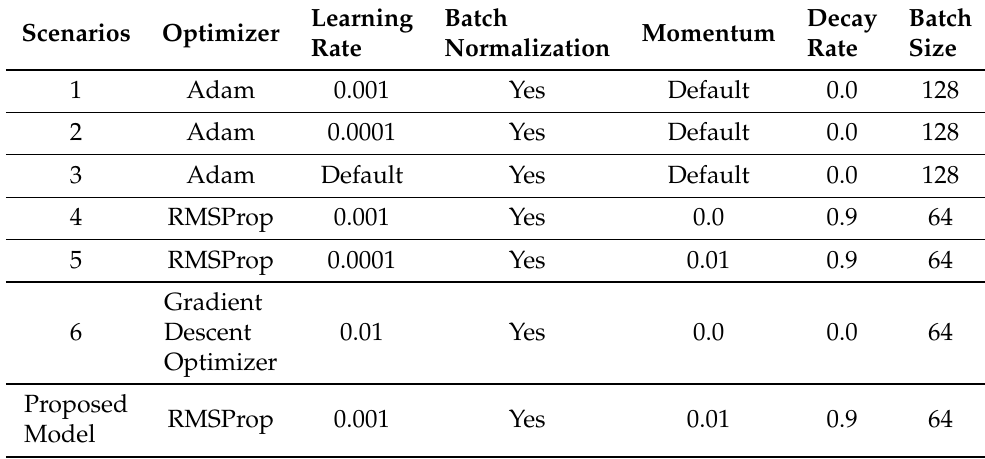
Table 6. Experimental